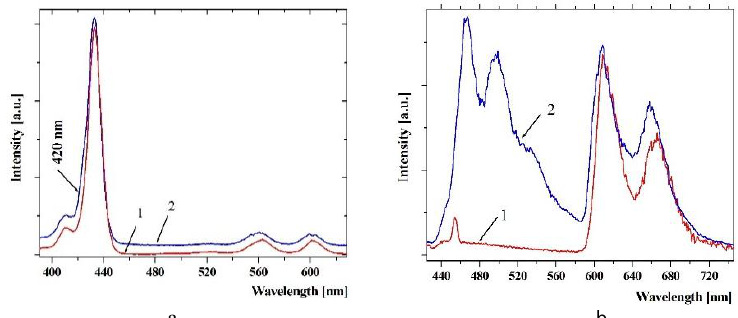
а b Fig. 2. Fluorescence excitation (a) and fluorescence (b) spectra of ZnATPP (1) and ZnATPP-СURC (2) in toluene at 77